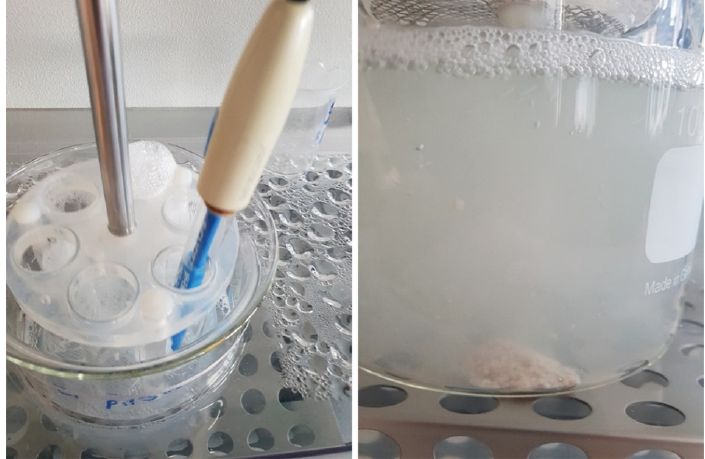
Figure 3. Pictures of Lipancrea ® 16000 after 60 min in buffer at pH 6.0. Foaming was observed during the test. After 60 min at pH 6.0, a single sticky mass was present at the bottom of the reaction beaker for Lipancrea ®